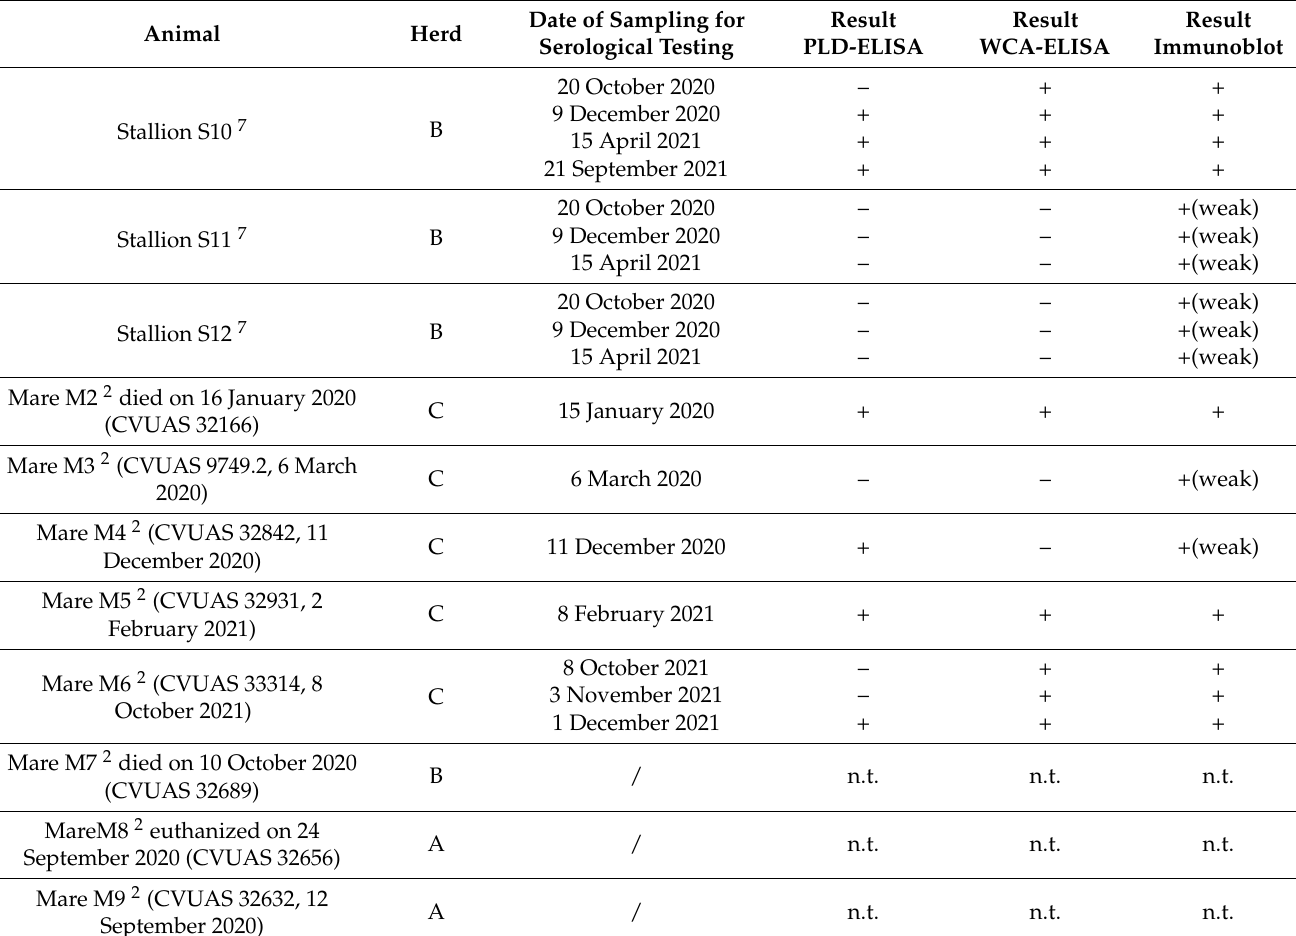
Table 2. Results of bacteriological and serological examinations on caseous lymphadenitis in selected alpacas in three herds. The name of the C. pseudotuberculosis isolates and the date of isolation are given in brackets in the first column.